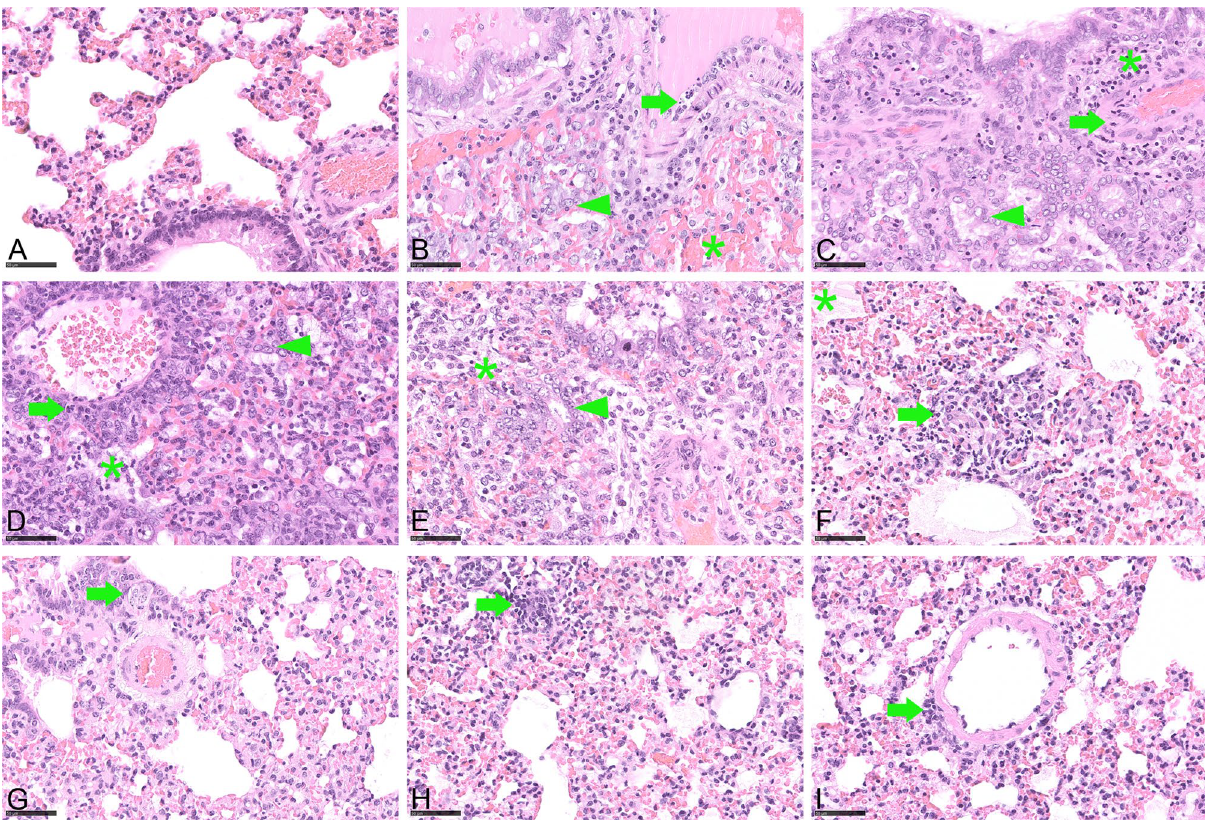
Figure 4. Detailed histopathology of hamster lungs, 10 days after orotracheal SARS-CoV-2 infection. Hematoxylin and eosin staining, bar 50 µm. ( A ) Uninfected control, no lung lesion, ( B ) after 1 * 10 4.5 TCID 50 infection, showing vasculitis (arrow), type 2 pneumocyte hyperplasia and bronchialisation of alveoli (arrowhead), intra-alveolar erythrocytes (asterisk), ( C ) after 1 * 10 2 TCID 50 infection, with vasculitis (arrow), type 2 pneumocyte hyperplasia and bronchialisation of alveoli (arrowhead) and perivascular infiltrates (asterisk), ( D ) after 1 * 10 0 TCID 50 infection exhibiting perivascular (arrow) and alveolar (asterisk) infiltrates, type 2 pneumocyte hyperplasia and bronchialisation of alveoli (arrowhead), ( E ) after 1 * 10 −1 TCID 50 infection, showing alveolar infiltrates (asterisk), type 2 pneumocyte hyperplasia and bronchialisation of alveoli (arrowhead), ( F ) after 1 * 10 −2 TCID 50 infection, with focal alveolar infiltrates (arrow) and edema (asterisk), ( G ) after 1 * 10 −3 TCID 50 infection, exhibiting focal hypertrophy/hyperplasia of bronchial epithelium (arrow), ( H ) after 1 * 10 −4 TCID 50 , with focal alveolar infiltrates (arrow), ( I ) after 1 * 10 −4 TCID 50 showing focal perivascular infiltrates